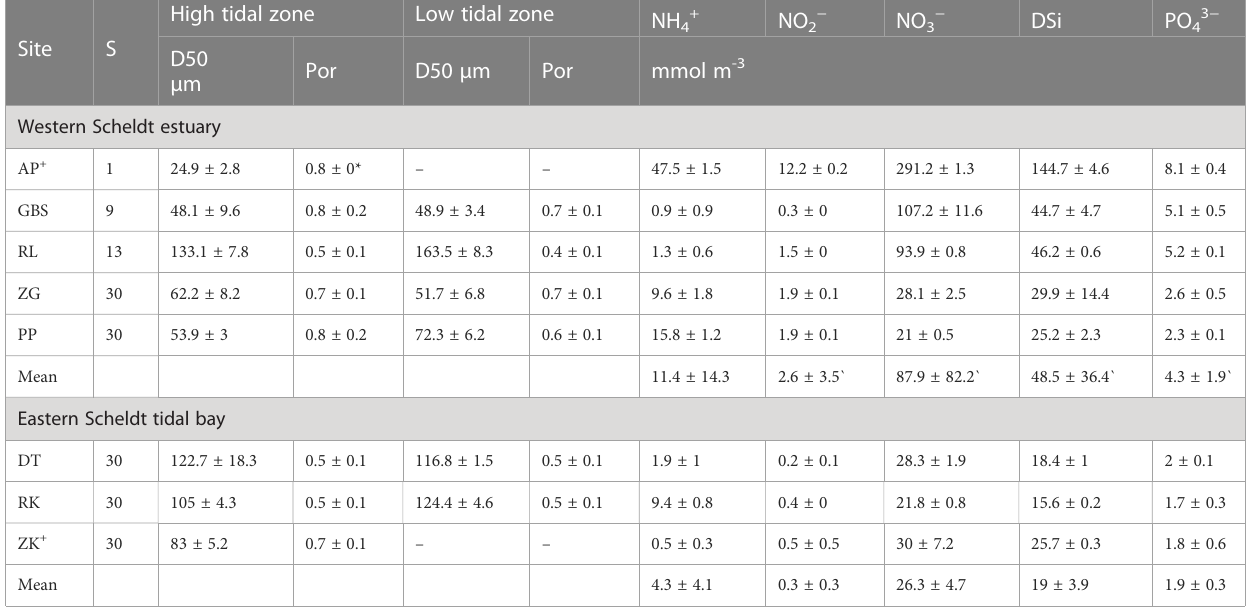
TABLE 1 Abiotic characteristics of the sediment (top 5 cm) and water column at the different sites of the Eastern Scheldt and Western